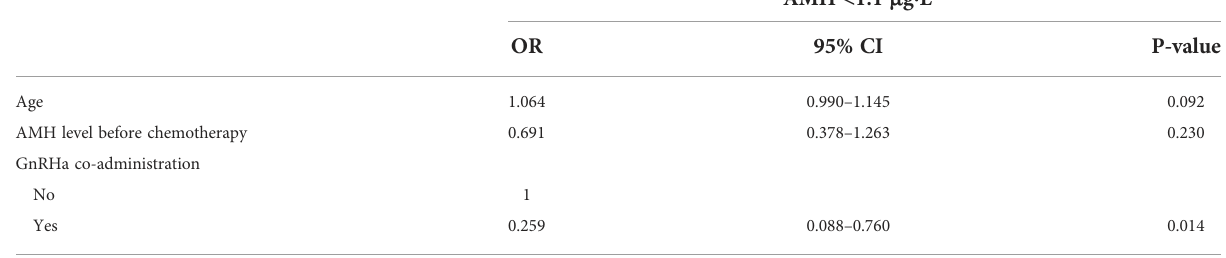
TABLE 6 Multivariate logistic regression analysis of factors contributing to AMH <1.1 m g·L -1